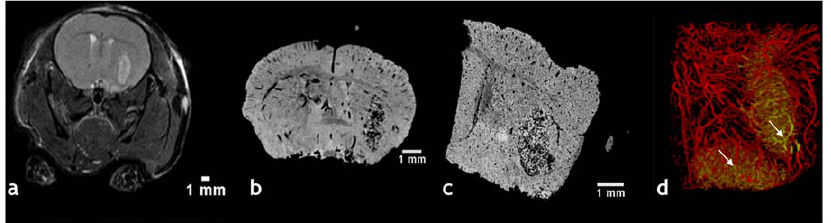
Figure 5. Multi-scale MRI of a 9L brain tumor model. (a) In vivo T 2 -weighted MRI at the ‘systemic’ scale ( , 150 m m); ex vivo m MRI at two ‘intermediate’ scales: (b) , 60 m m, and (c) , 30 m m. (d) Ultra-high resolution vascular m MRI image in which vessels have been segmented into tumor vessels (gold) and normal vessels (red). One can clearly visualize the abnormal tumor vessel architecture and changes in vessel morphology at the tumor-host tissue interface (arrows).